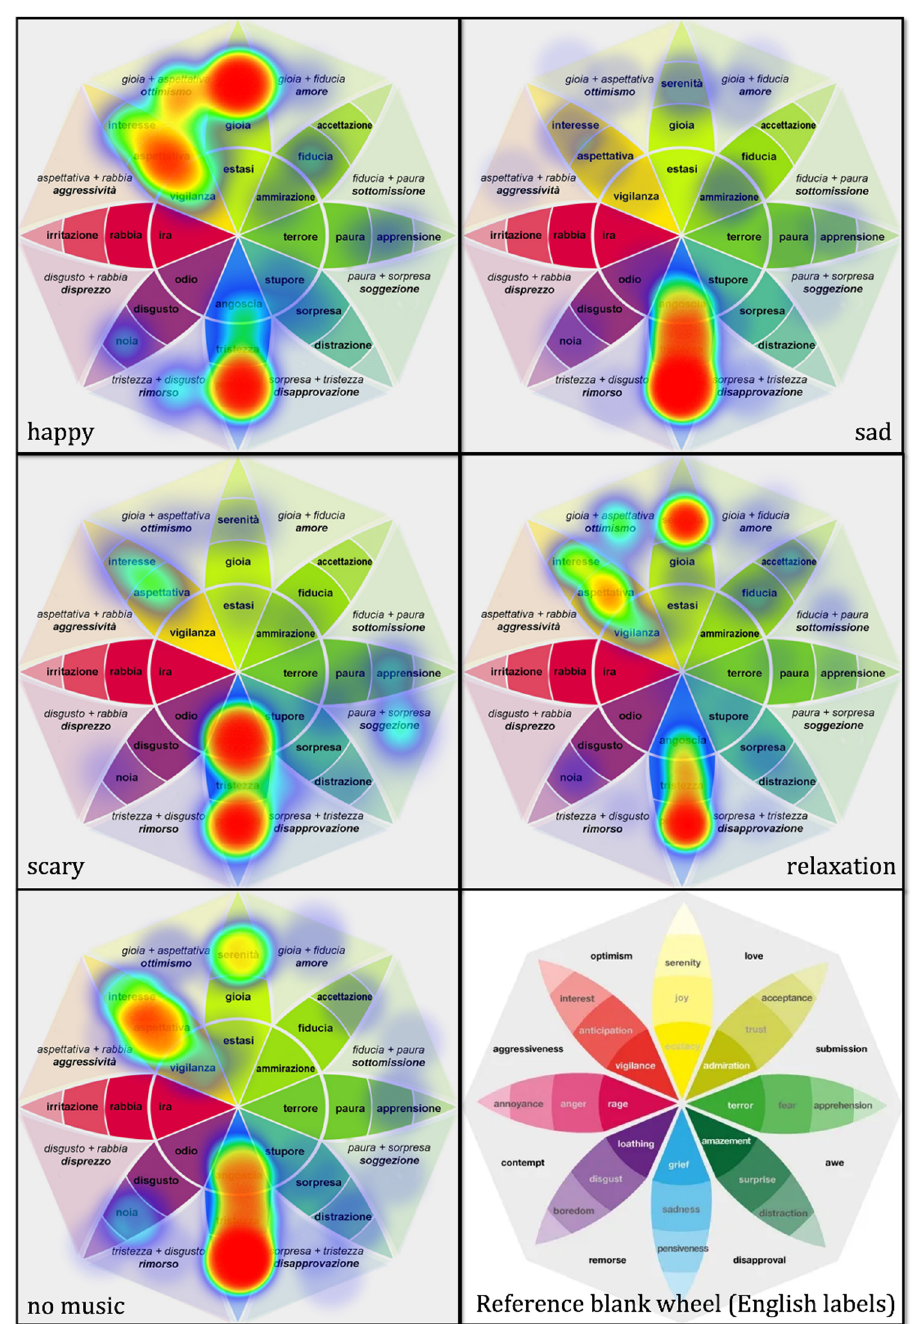
Figure 2. Heatmaps of the participants’ affective state in each condition. Heatmaps visualize, in an aggregated fashion, the most frequently clicked (hot) and unclicked (cold) emotions using colors on a scale from red to blue. At the bottom right, a blank wheel with English labels is presented to facilitate comparisons.